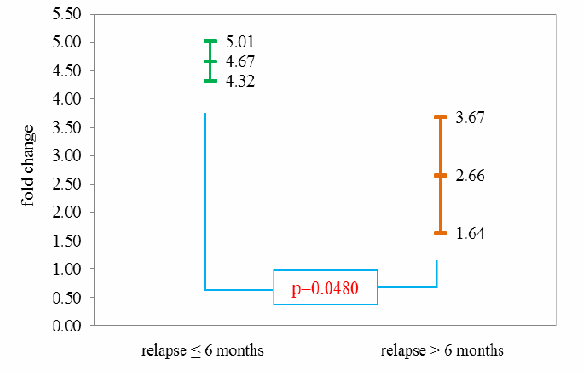
Fig. 2. Mean fold change values for IDO1 in lesional areas (95% CI values of FC) according to relapse